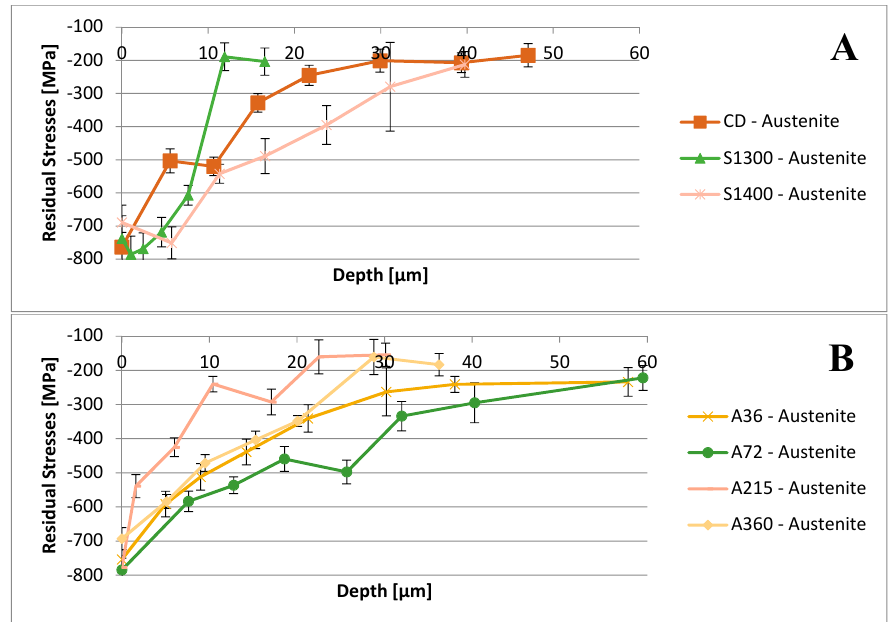
Figure 3. Depth profiles of the residual stresses induced by shot peening treatment within the austenitic phase: CD, S1300, S1400 samples ( A ) and A36, A72, A215, A360 ( B ).